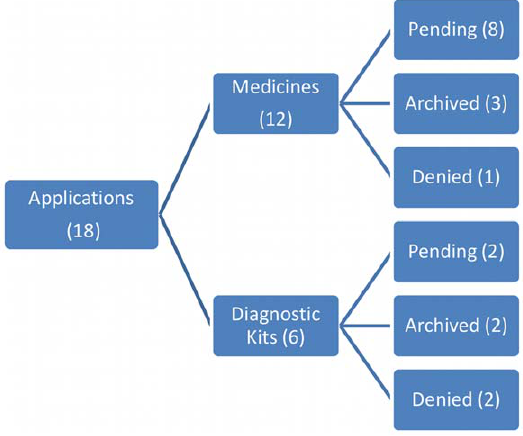
Figure 7. Status of patent applications related to TB medicines or diagnostics applied by Brazilian nationals,